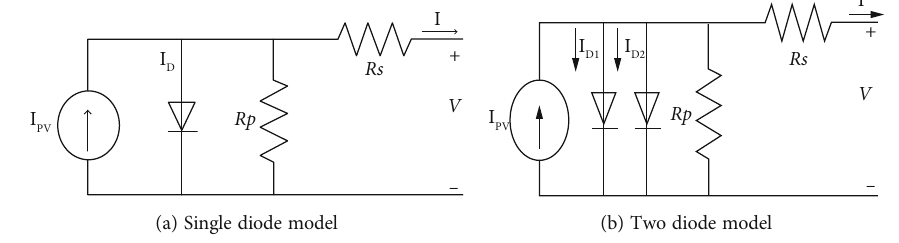
Figure 1: One and two diode model of solar cell.